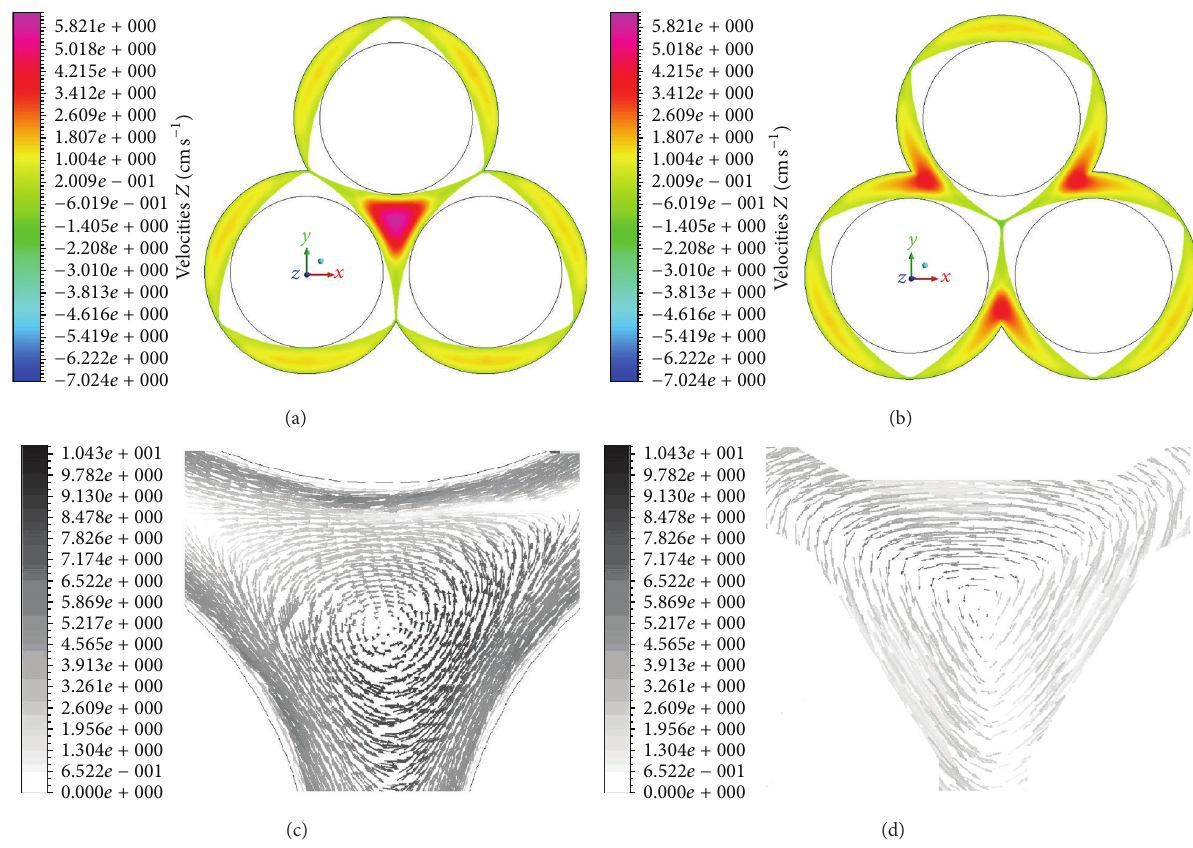
Figure 2: Contour map of axial velocity at different cross sections: (a) 𝑡 = 0.25 s; (b) 𝑡 = 0.5 s; (c) in center region at 𝑡 = 0.25 s; (d) in center region at 𝑡 = 0.5